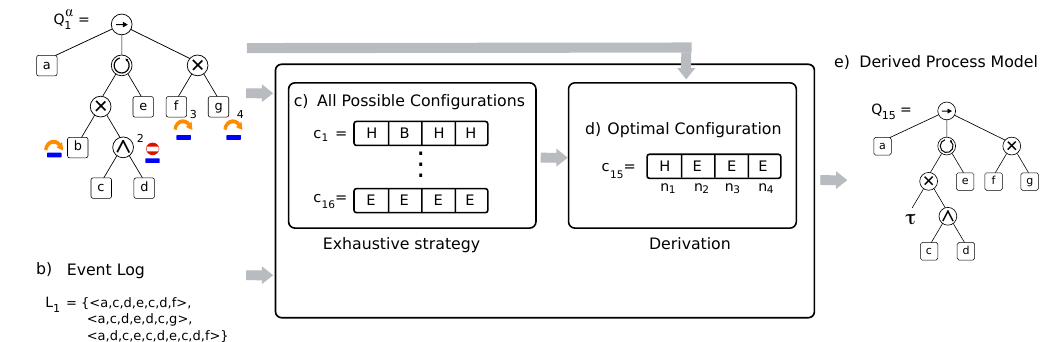
Figure 6. Overview of the exhaustive strategy to derive a process tree. The algorithm generates all possible configurations, in order to find an optimal configuration. This configuration is used to obtain an optimal derived process tree.